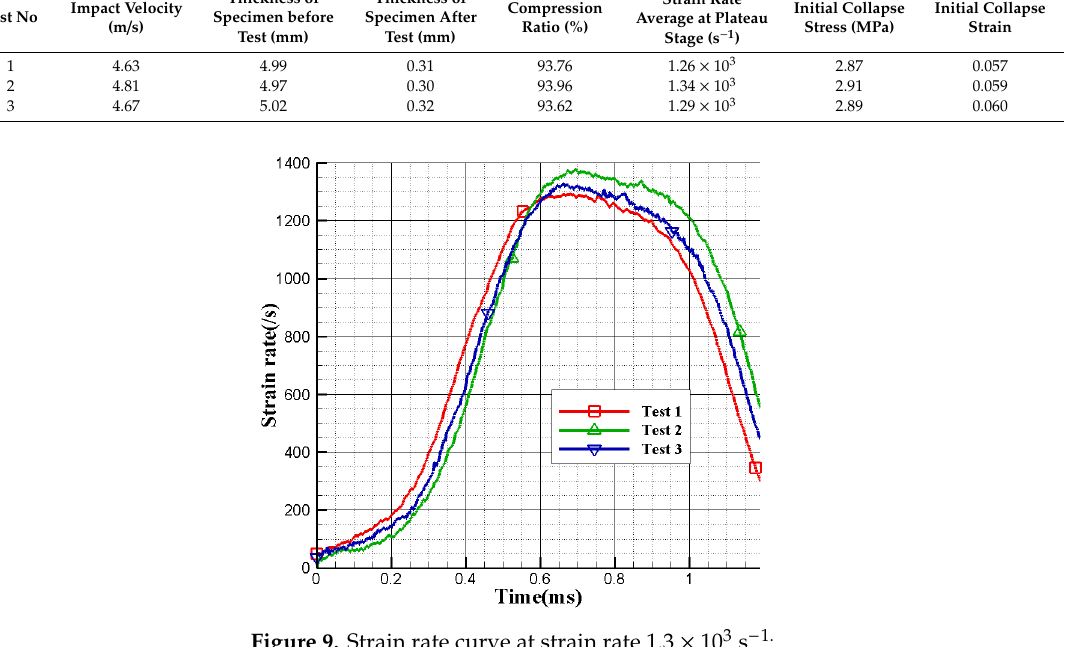
Figure 10. Stress–strain curve at strain rate 1.3 × 10 3 s –1 . To obtain the macroscopic mechanical property of aluminum honeycomb structures at a strain rate of 1.3 × 10 3 s –1 , the average value of the strain rate curve and stress–strain curve from the three tests are obtained after interpolation.